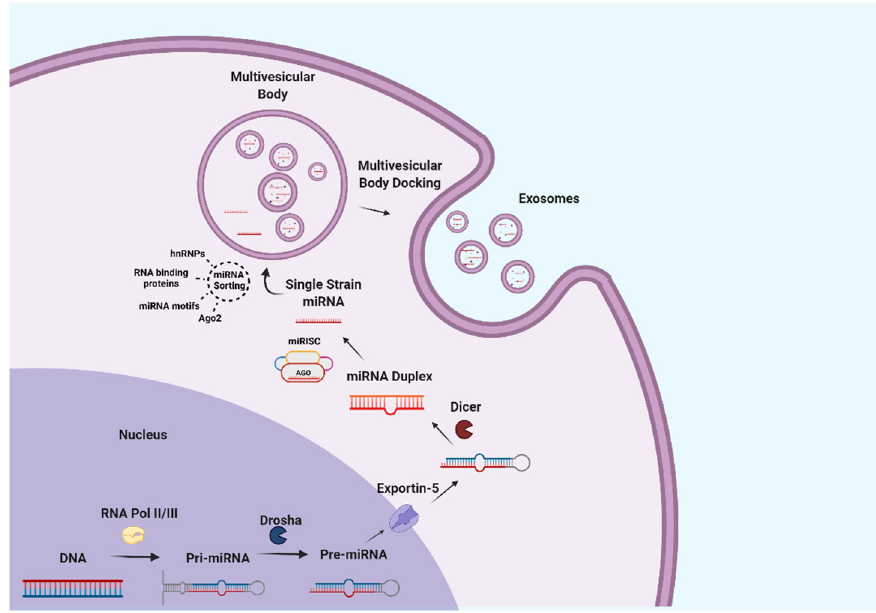
Figure 2. MiRNA synthesis and loading into milk exosomes.